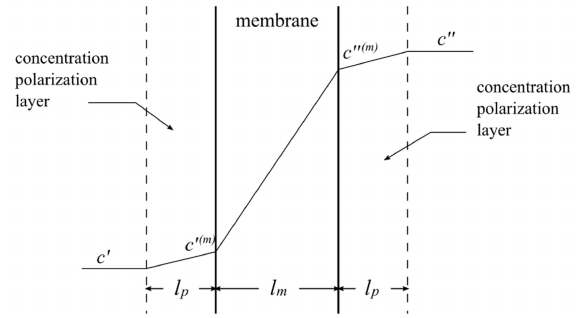
Figure 1. The system: ion-exchange membrane with adjacent boundary di ff usion layers. l p —thickness of concentration polarization layer; l m —thickness of the membrane; c (cid:48) , c”—concentrations of ions in the bulk solution; c (cid:48) (m) , c” (m) —concentrations of ions at the membrane